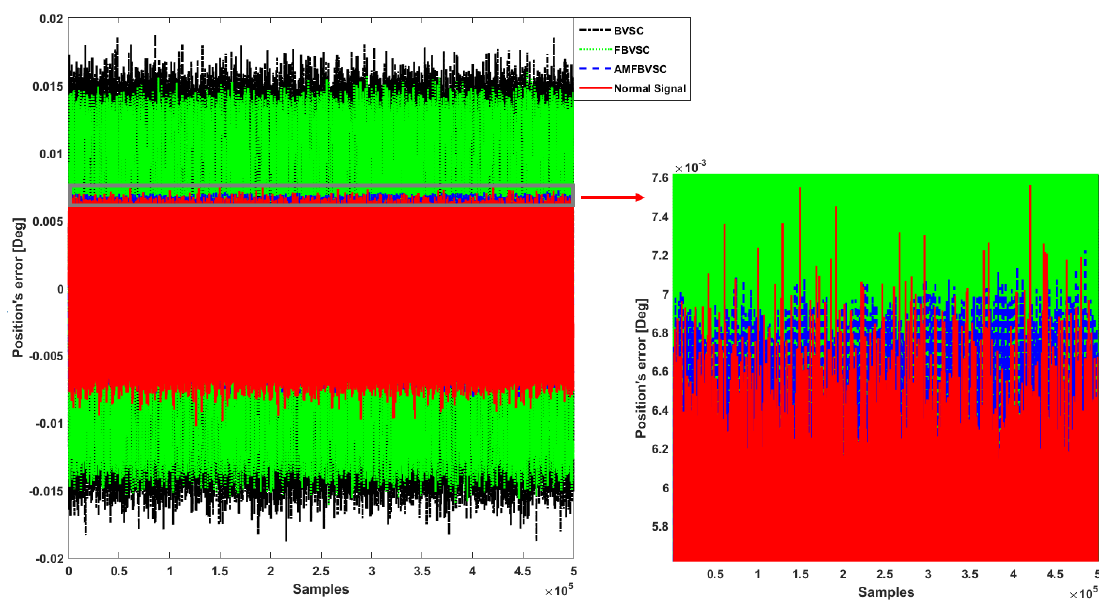
Figure 11. Actuator – sensor fault-tolerant control algorithm based on AMFBVSC, FBVSC and BVSC. Figure 11. Actuator–sensor fault-tolerant control algorithm based on AMFBVSC, FBVSC and